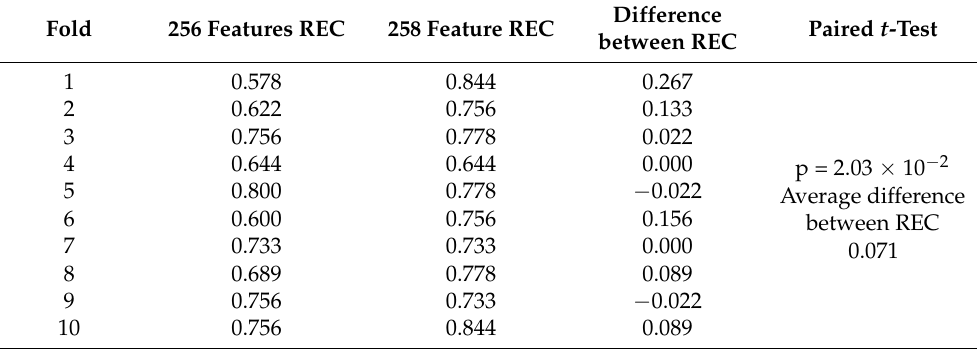
Table 7. Paired t -test of recall for 256 features vs. 258 features.